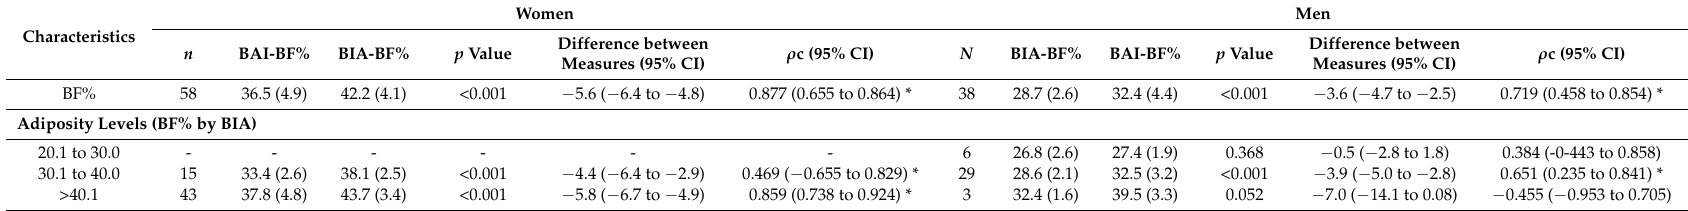
Table 3. Fat mass by BIA and BAI according to distinct levels of adiposity by